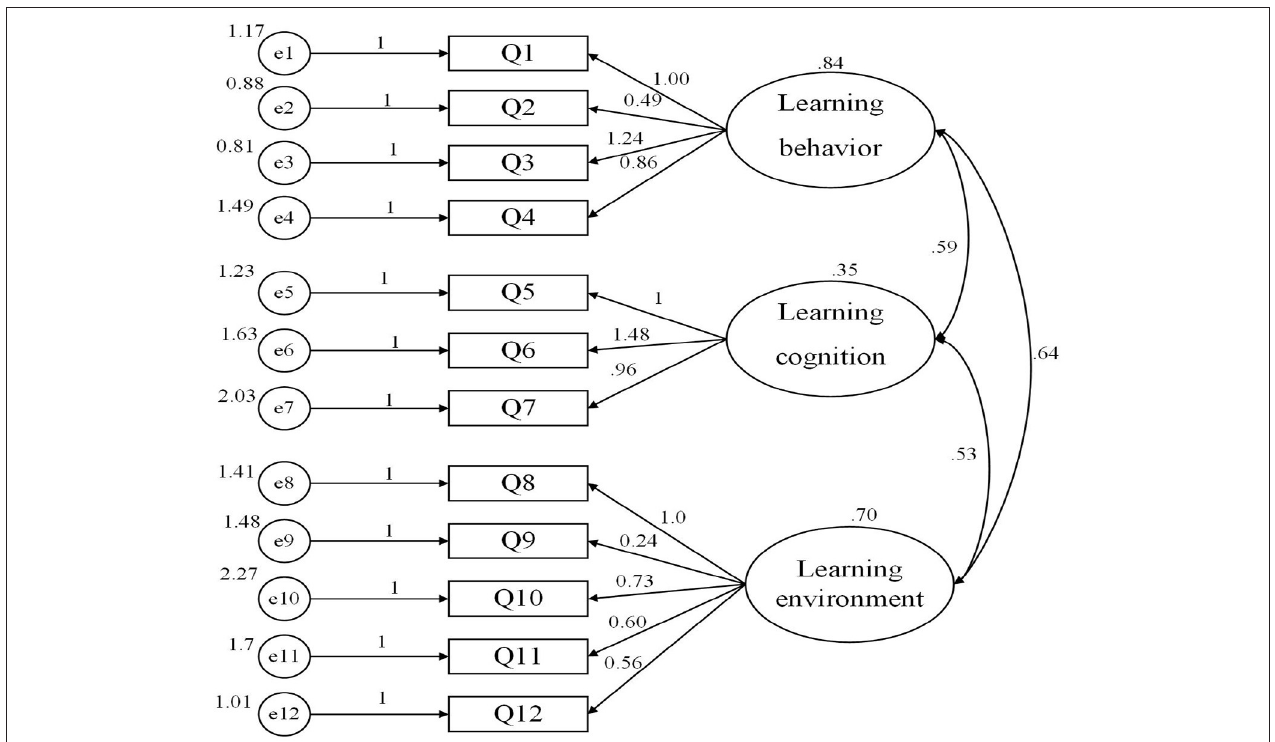
FIGURE 1 | Structure diagram of the measurement model of online learning’s effect on college students.